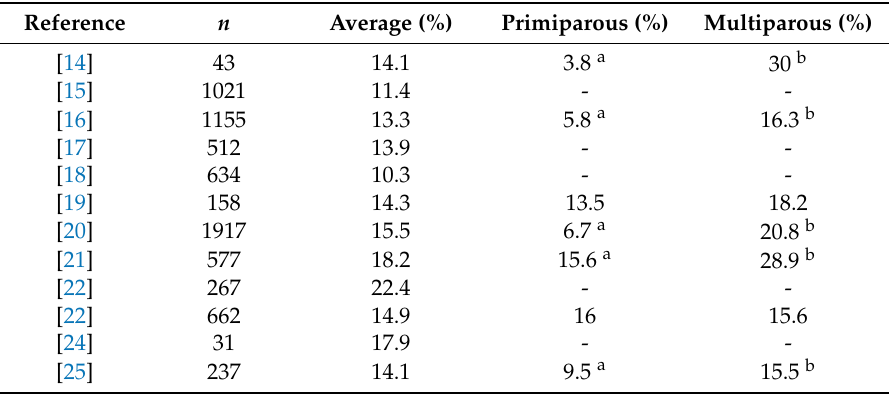
Table 1. The incidence of multiple ovulations (MOV) in lactating dairy